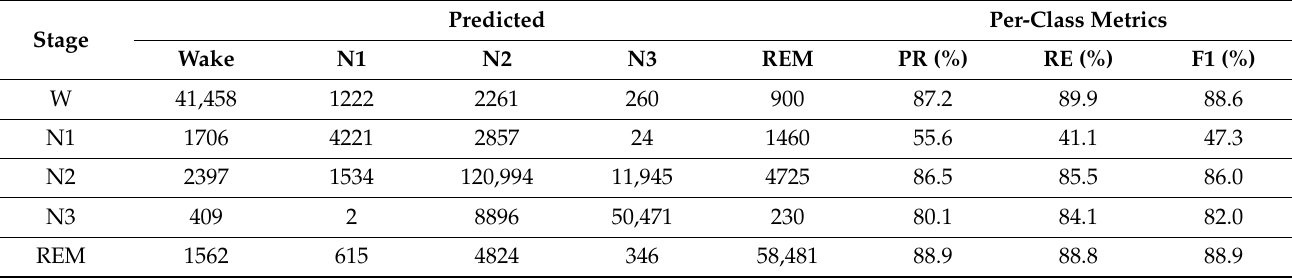
Table 6. Confusion matrix of Sleep-EDFX-SHHS